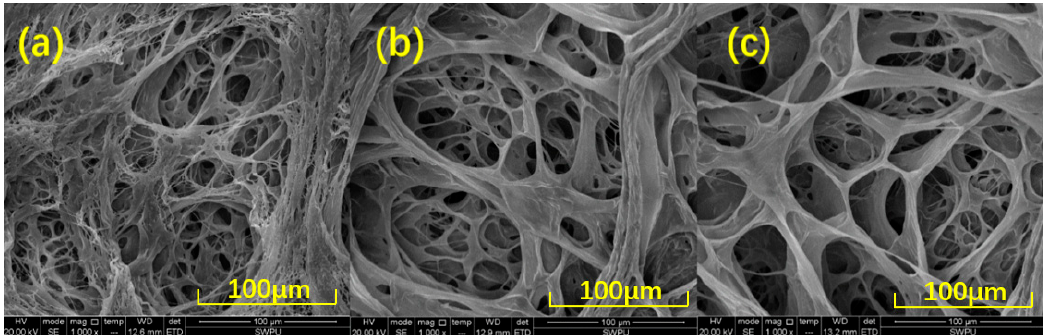
Figure 8. The thickening mechanism of HGP.